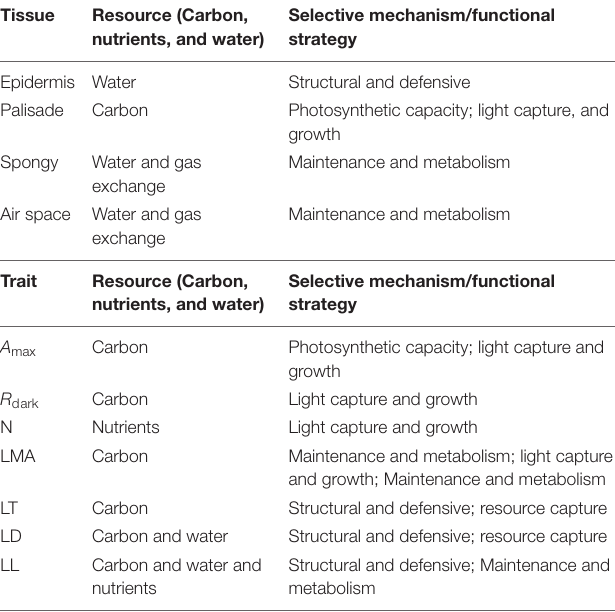
TABLE 2 | Functional strategy and primary resource invested of each anatomical tissue layer and